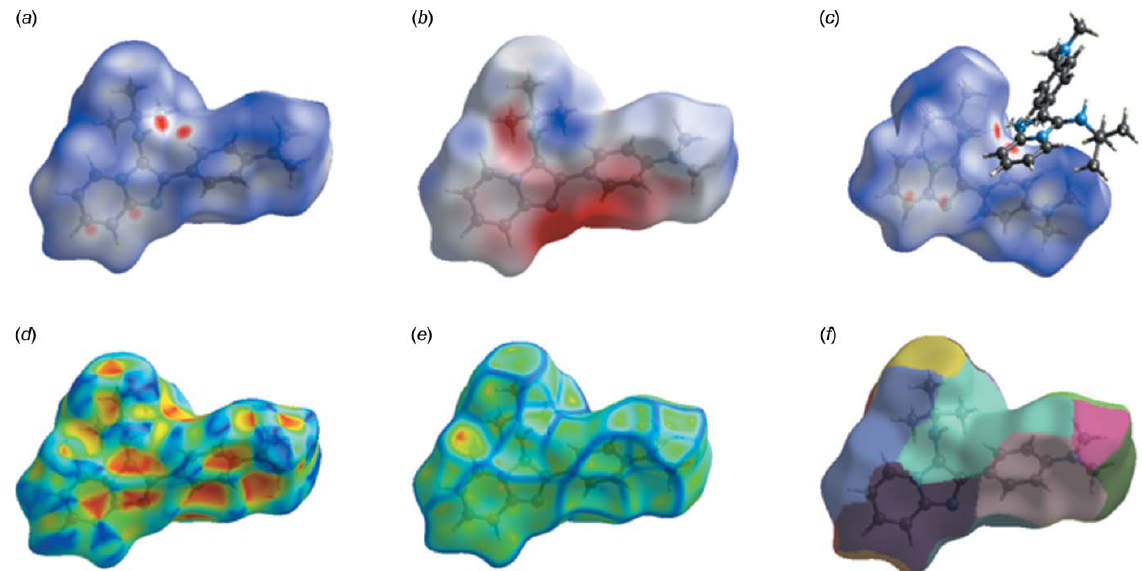
Figure 7 View of the Hirshfeld surface for compound (II), mapped over: ( a ) d norm ; ( b ) electrostatic potential; ( c ) intermolecular contacts; ( d ) shape index; ( e ) curvature; ( f ) fragment